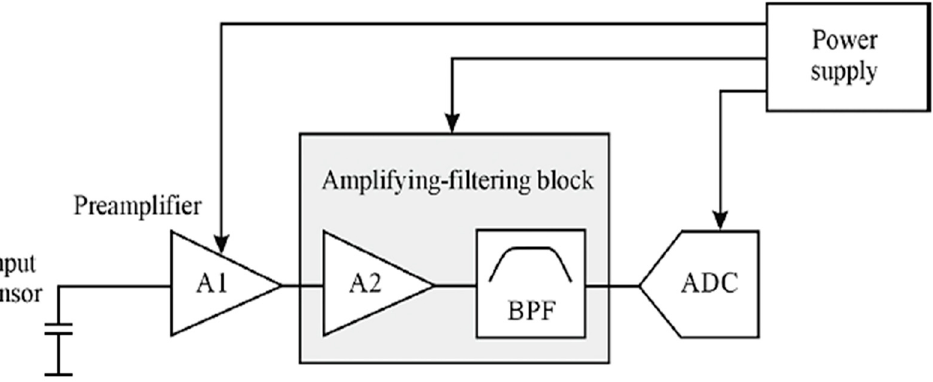
Figure 23. Block diagram of the front-end dedicated to the AlN-based piezoelectric sensors [129].